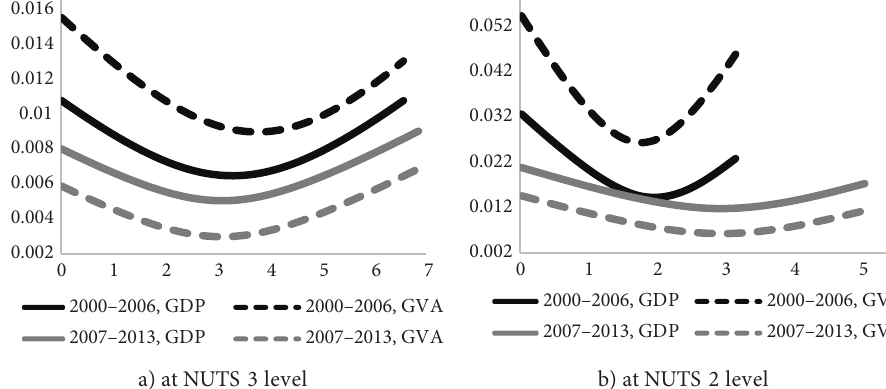
Figure 2. Estimated conditional effect, i.e. slope ( + × 1 2 DiD DiD i b b ICP , vertical axis) of CP transfers’ intensity ( i ICP , horizontal axis)